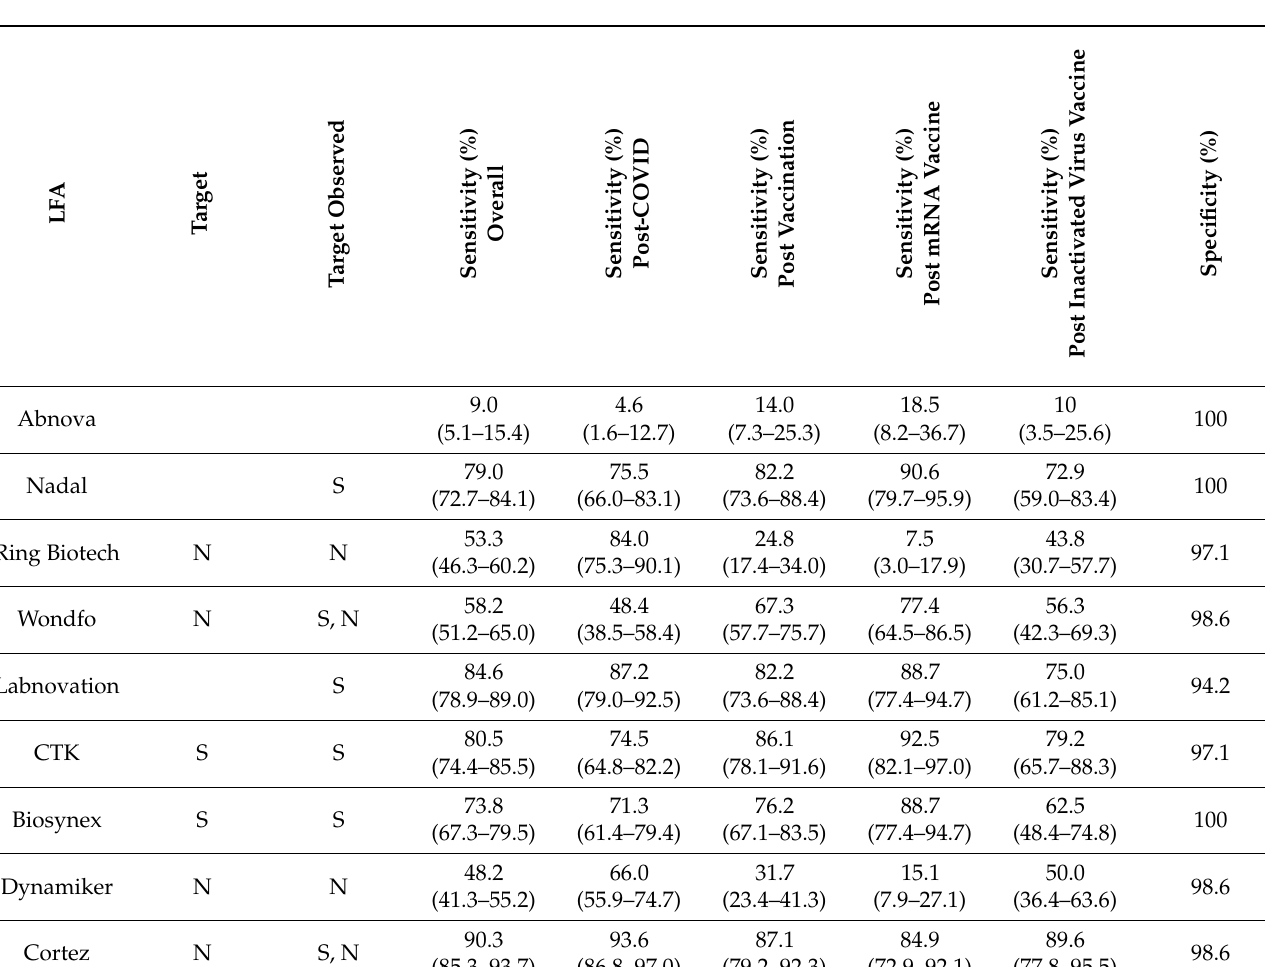
Table 3. Sensitivity of lateral flow assays with manufacturer announced target and observed target. The sensitivity was calculated for post-COVID-19 and post-vaccination patients (vaccinated with mRNA and inactivated virus